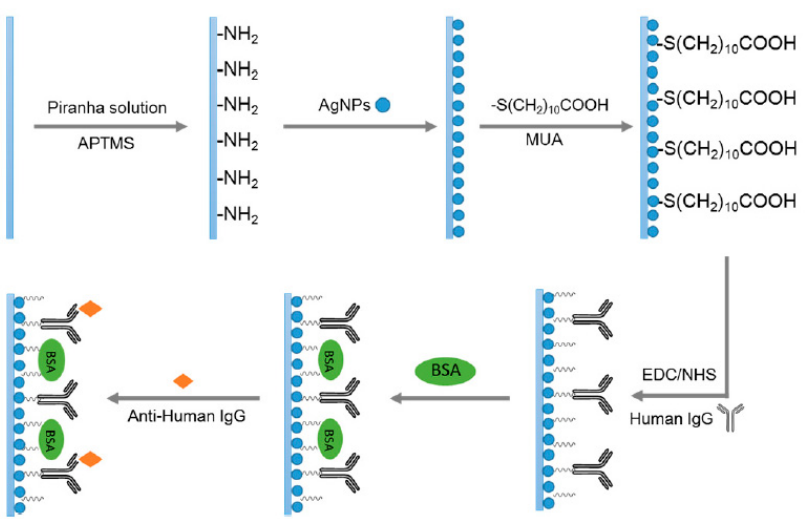
Figure 6. A summary scheme for the functionalization process of the AgNPs for biosensing applica- tions. Reprinted with permission of [26].